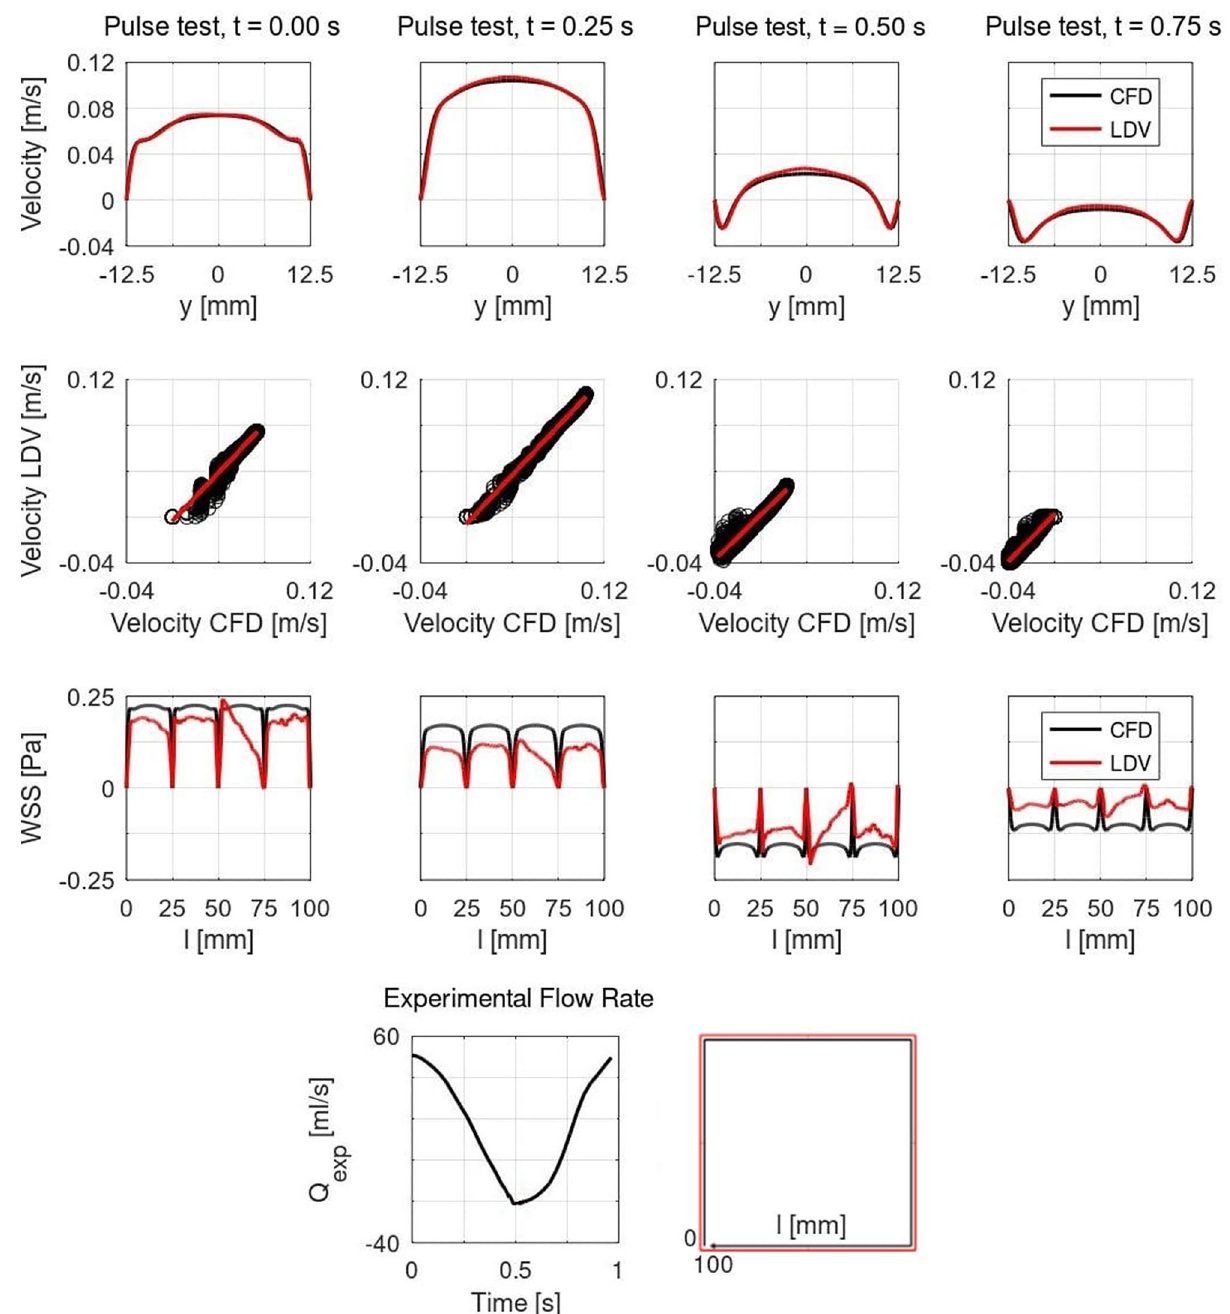
Figure 2. LDV verification with CFD for pulse test at different time frames. First row: Velocity centerlines; Second row: Correlation plots with regression lines in red; Third row: Finite difference WSS profiles on the test section boundaries expressed in Pa, results are plotted along the boundary coordinate l , 0 ≤ l ≤ 100 mm; Fourth row: Flow rate (left) and schematic of the boundary coordinate l to plot WSS profiles